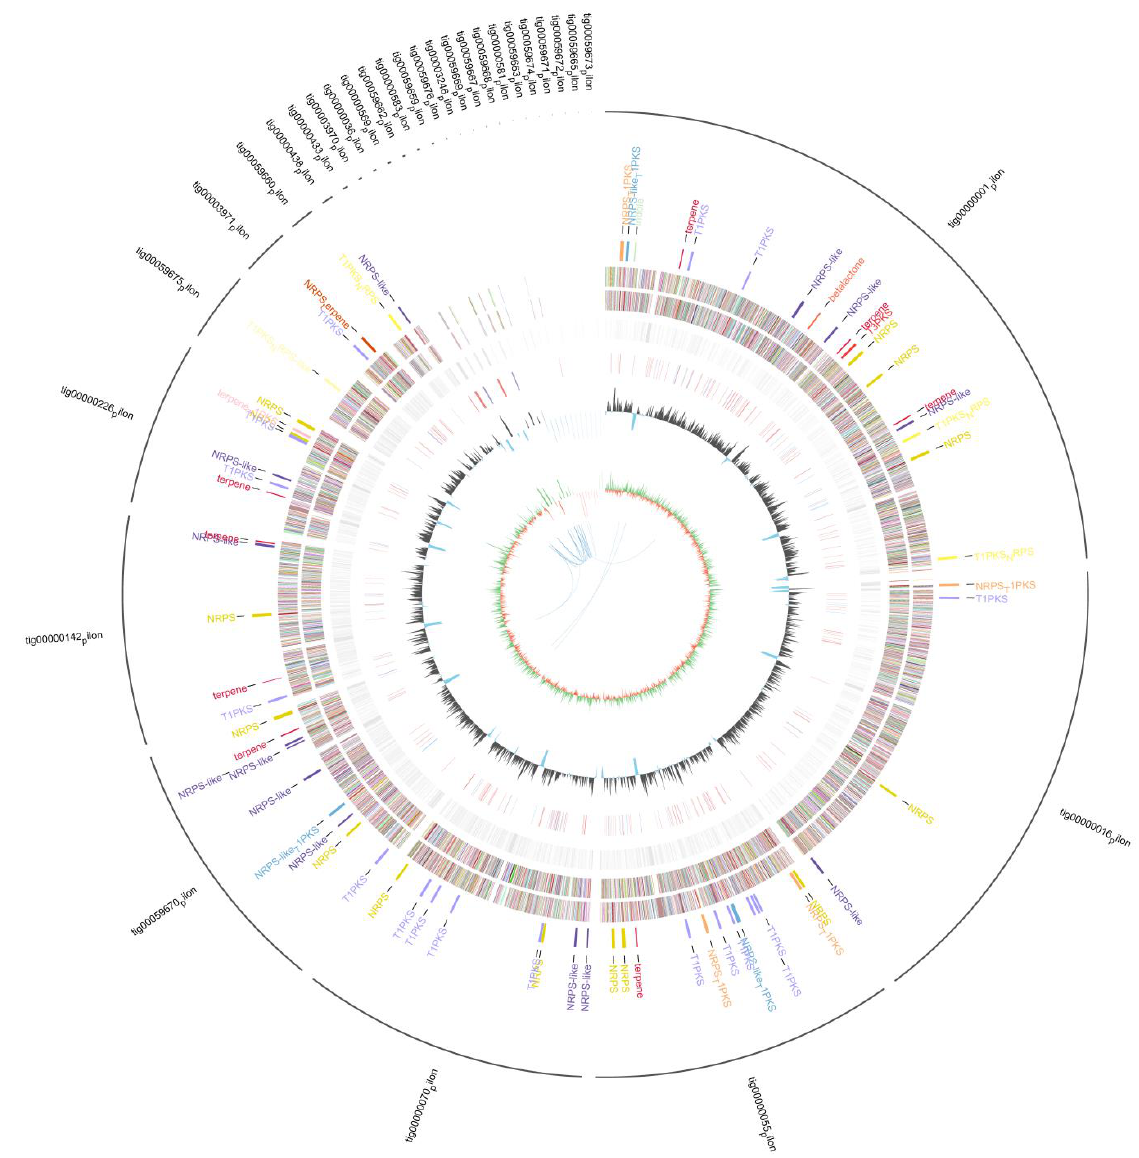
Figure 2. Genome diagram of strain L14 (from inside to outside: the first circle of blue lines shows in-paralog pairs better hits between each other, the E-value between pairs is lower than 1 × 10 − 5 ; the second circle shows GC skew, green is the positive part of GC skew, orange is the negative part of GC skew; the third circle shows the GC content; the fourth circle shows ncRNA; the fifth circle shows the repeat; the sixth circle and the seventh circle show the CDS annotation information, and different colors represent different COG annotation classifications; the sixth circle is the CDS in the negative chain; the seventh circle is the CDS in the positive chain; the eighth circle shows the SMs, where the corresponding gene cluster names are marked; the outermost circles show the various scaffolds).